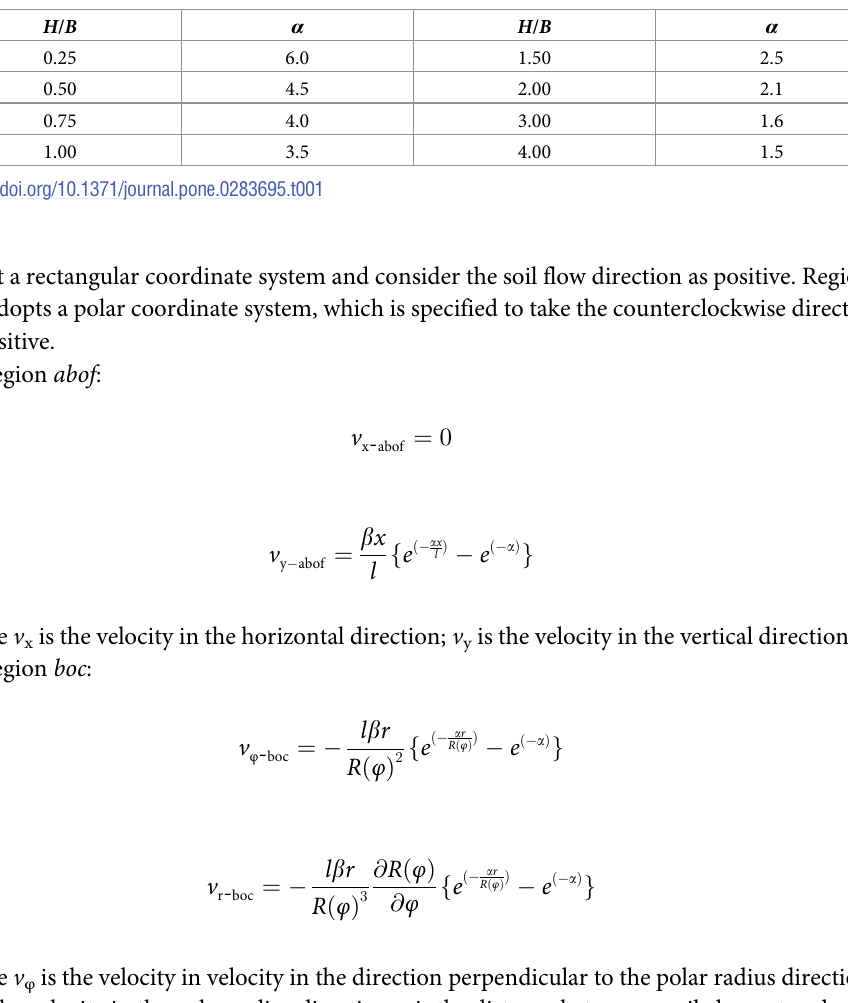
For the sake of obtaining the minimum upper bound solution [7] it has a and a ¼ l (cid:0) B when H / B > 0.25. 2 2 Region cdeo :